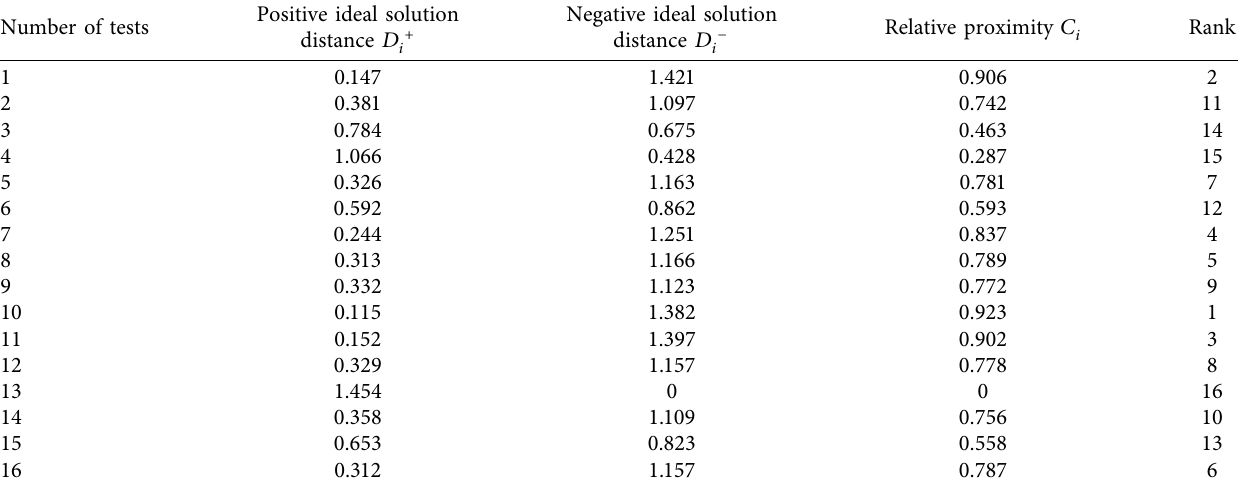
Table 8: TOPSIS evaluation